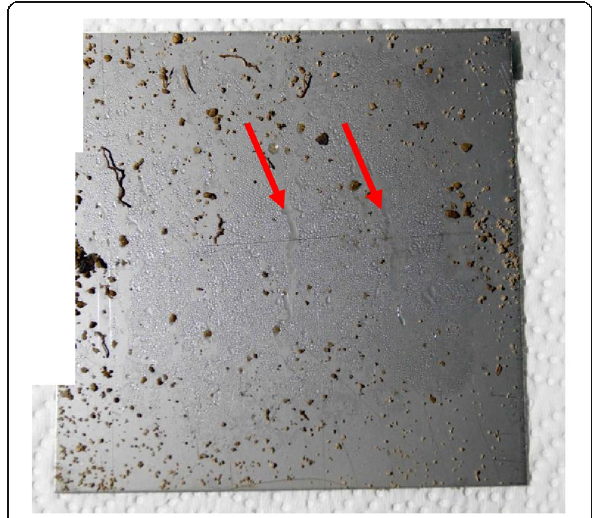
Fig. 13 The formation of water speckles on metal plates bearing the fingermarks ( “ face down ” )